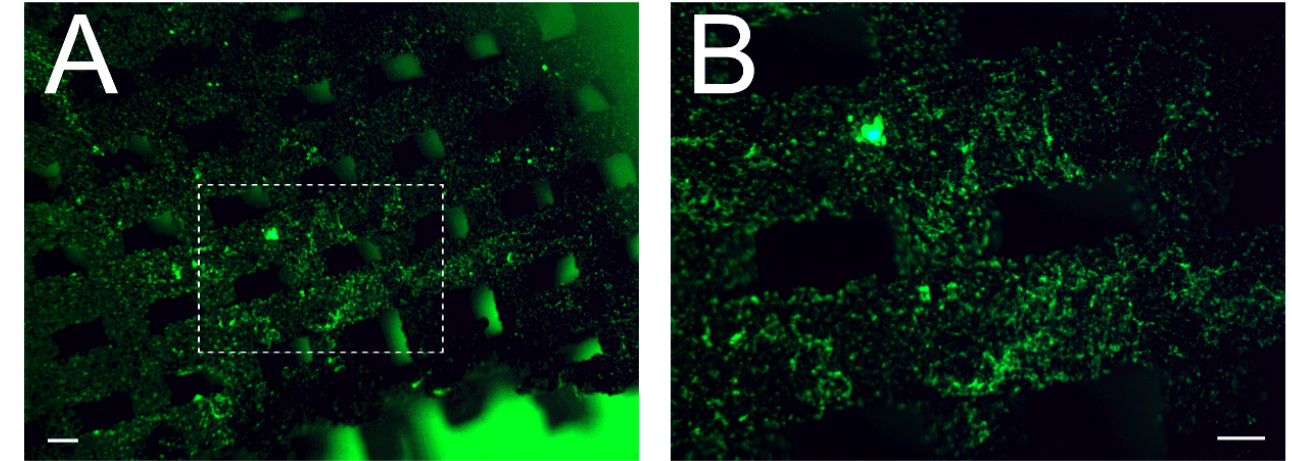
Figure 5. Characterization of scaffold functionalization. Low- ( A ) and high-magnification ( B ) fluorescence images of HRGD-functionalized Ti scaffolds. Samples were crushed and longitudinally observed. Scale bar denotes 200 μ m.